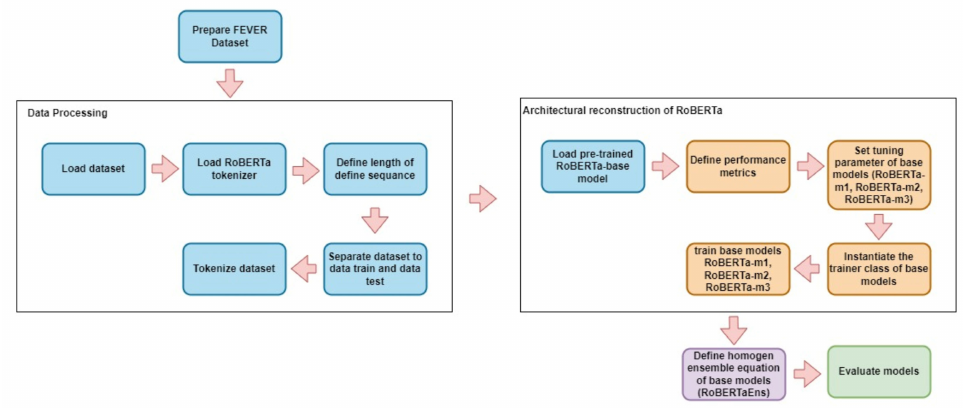
Figure 3. RoBERTaEns